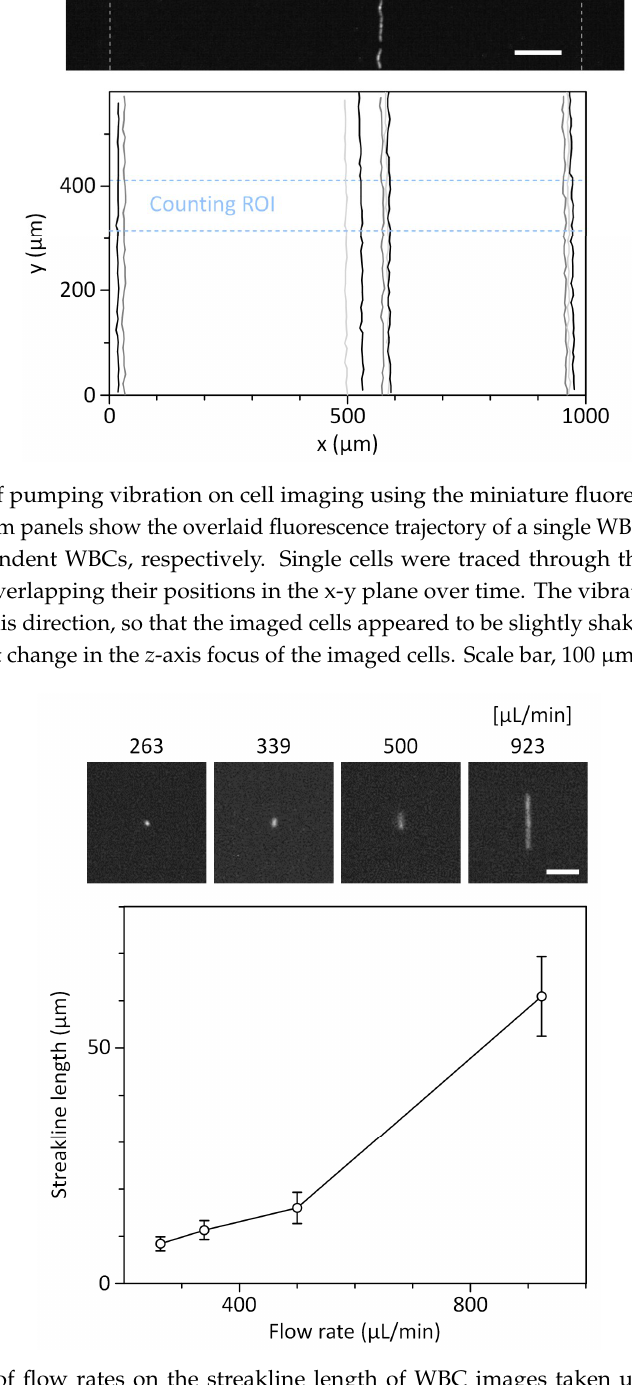
Figure 6. Effect of flow rates on the streakline length of WBC images taken using the miniature fluorescence microscope ( n = 20 cells for each data point). The flow rates were generated in the microfluidic cell concentrator using the smart pipette with set pressures of 80, 105, 135, and 150 kPa, respectively, in ascending order. Scale bar, 40 µm.